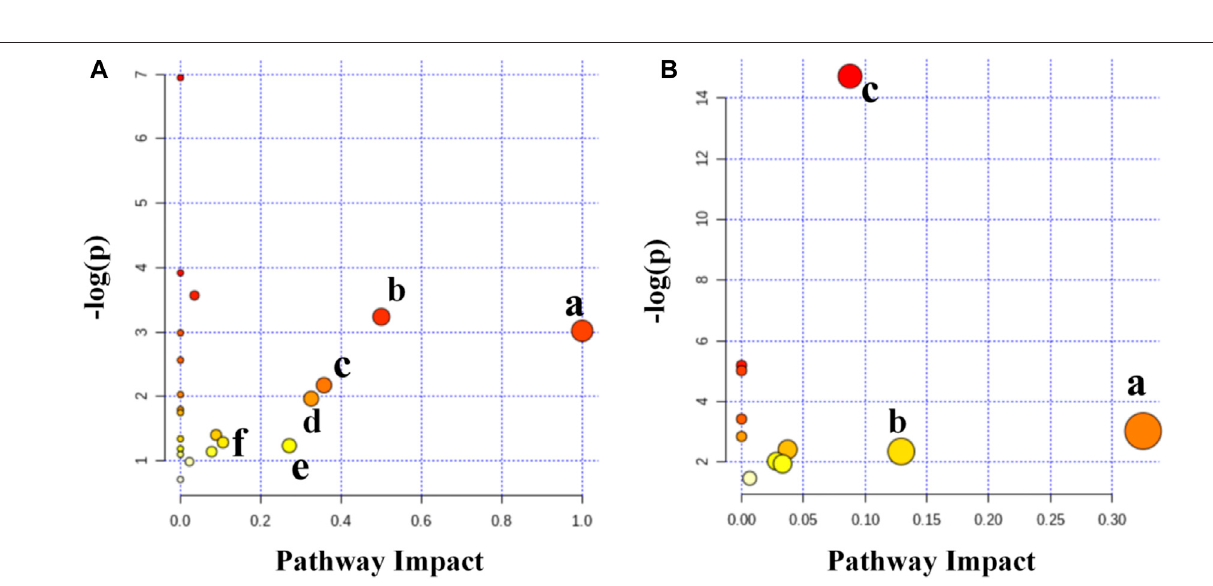
Frontiers in Pharmacology |